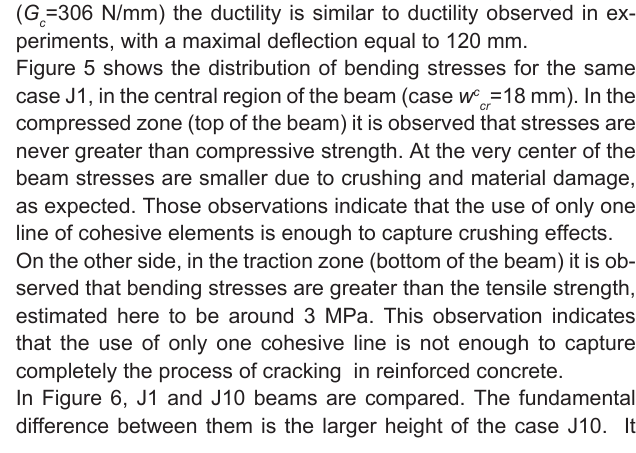
Figure 6 – Comparison of numerical and experimental results [14] for J1 and J10